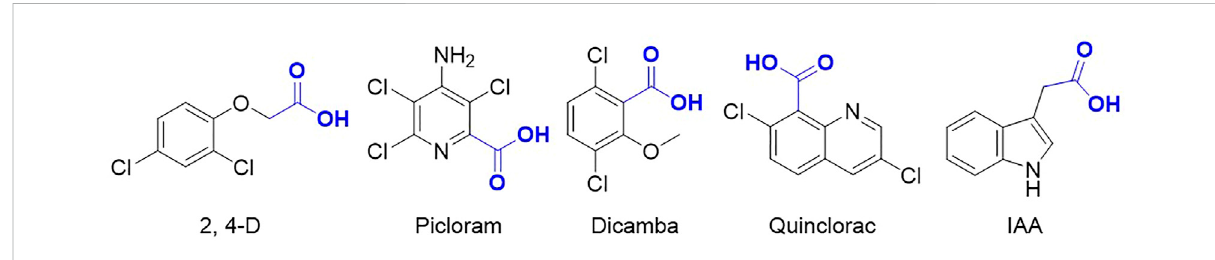
FIGURE 1 Chemical structures of typical auxinic herbicides and indole-3-acetic acid